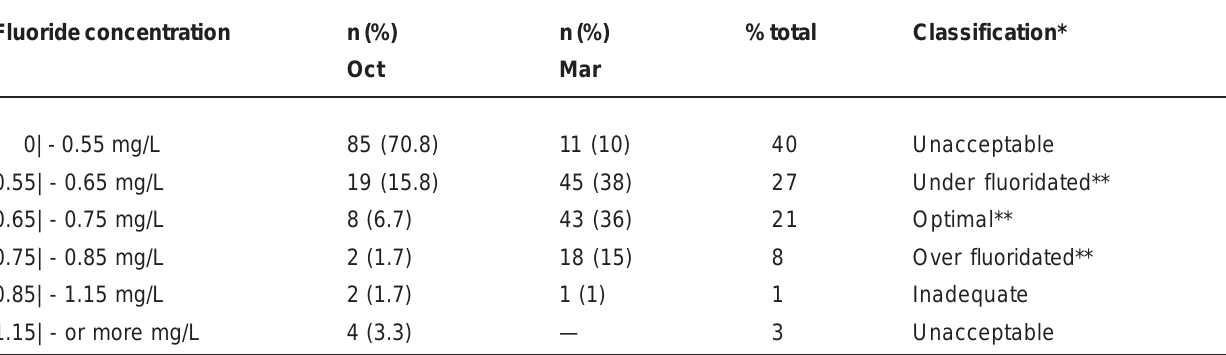
TABLE 2 - Classification of water samples according to fluoride concentration, collected in October 2002 and March 2003 n (%) in Bauru, SP,